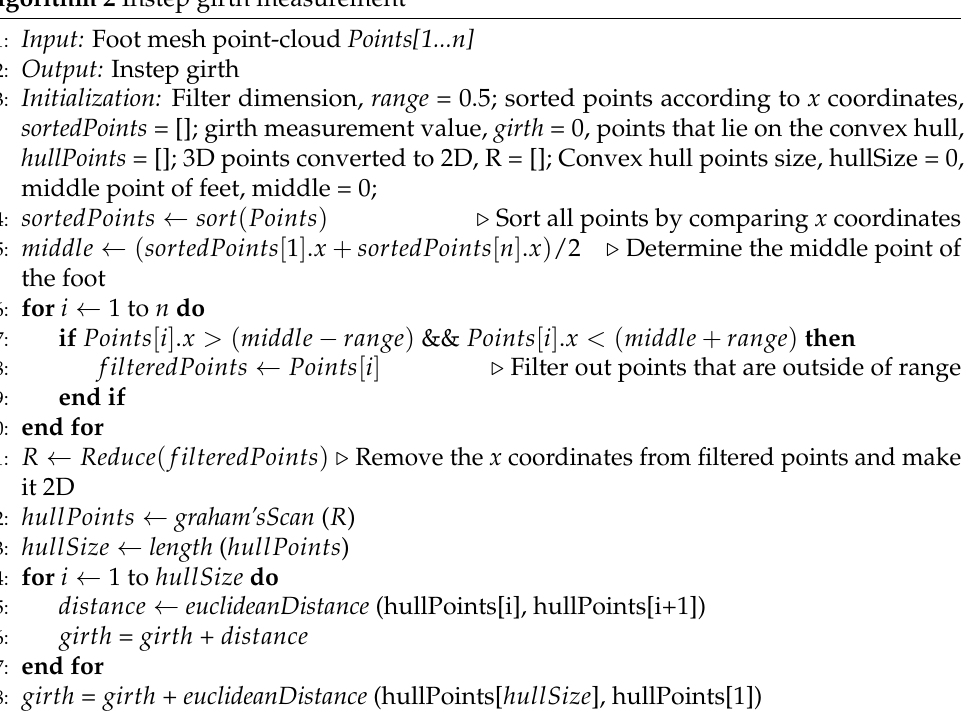
Algorithm 2 Instep girth